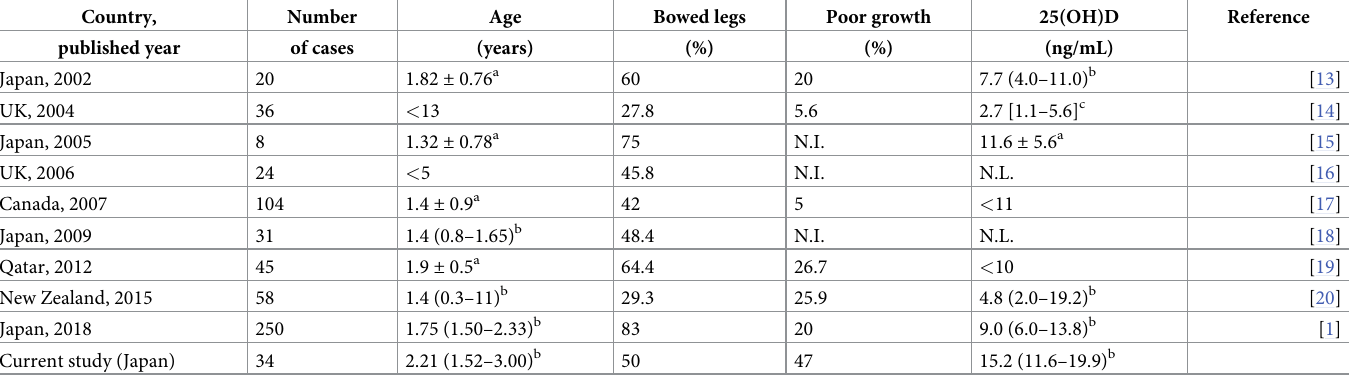
Table 3. Summary of previous reports associated with vitamin D deficiency rickets in childhood.